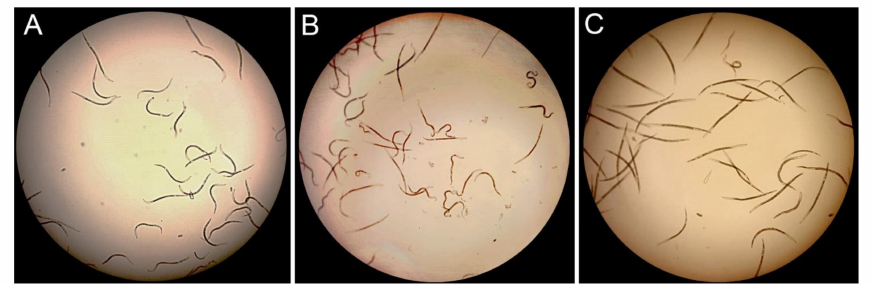
Figure 6. RNAi-mediated phenotypes of P. loosi nematodes treated with dsRNA gfp ( A ), untreated ( B ) and dsRNA Pl-eng -2 ( C ) after 24 h of soaking at 23 ◦